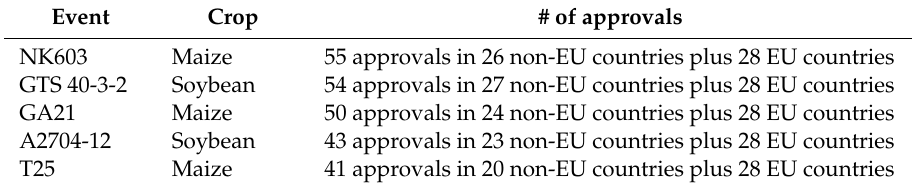
Table 3. Global approvals of herbicide-resistant maize and soybean transgenic events